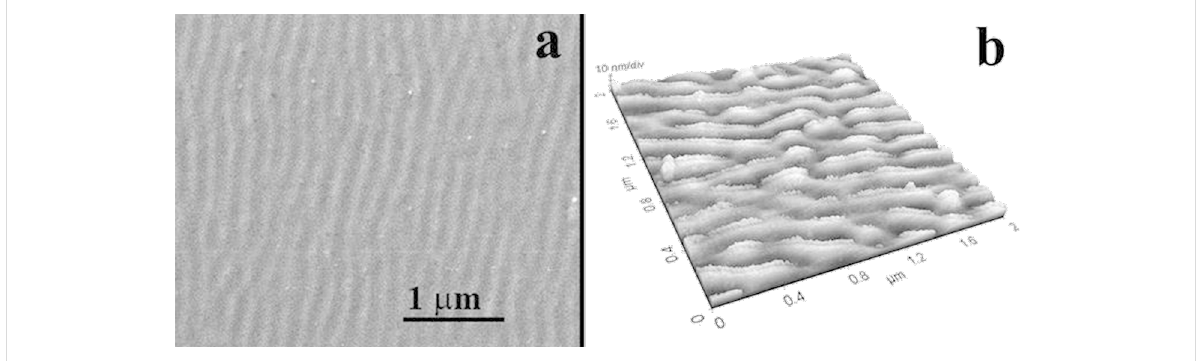
Figure 1: Surface relief of the GeTiO film after laser irradiation with 100 laser pulses at 15 mJ/cm 2 fluence. (a) SEM image and (b) AFM image.